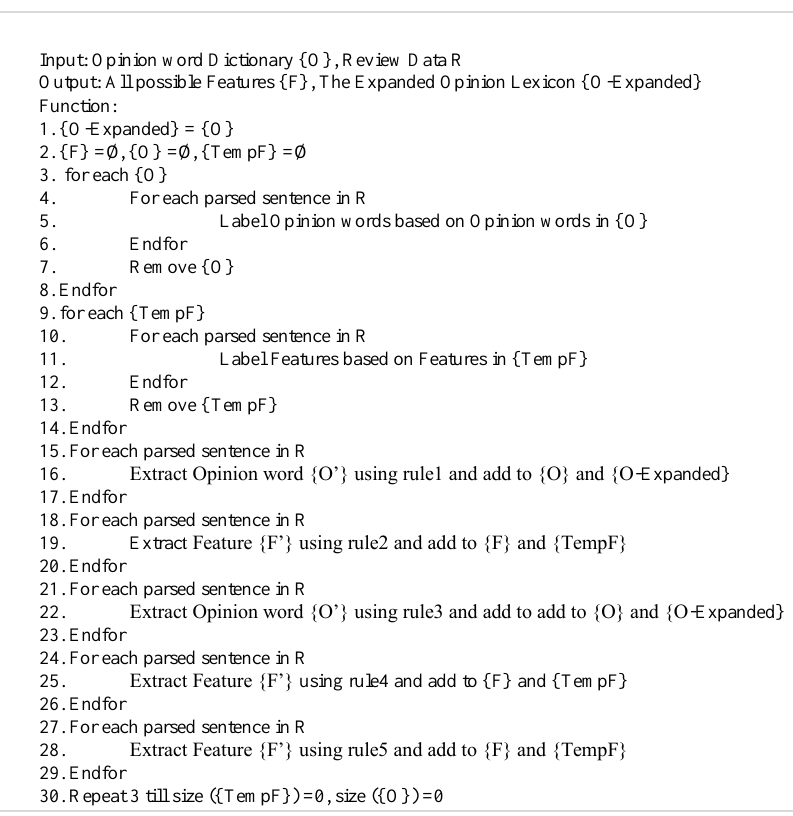
Figure 2. Dependency grammar based feature extraction .